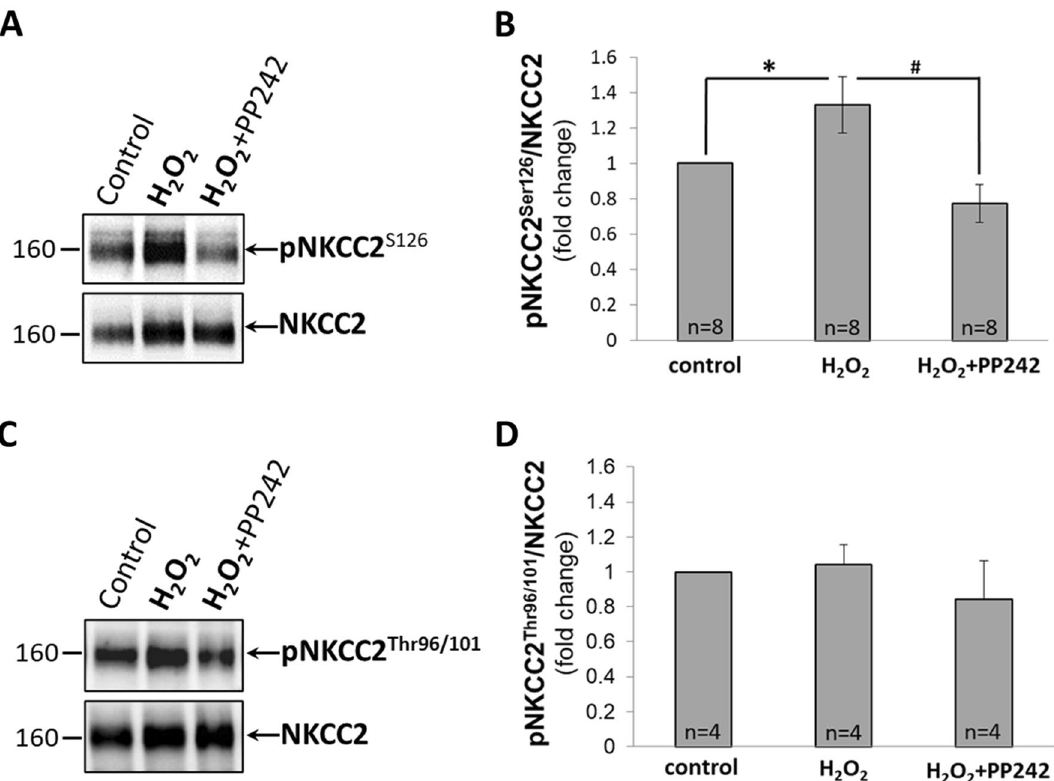
Figure 5. ( A , C ) Representative Western Blot of total NKCC2 and phosphorylated NKCC2 cotransporters (pNKCC2 Ser126 ( A ) and pNKCC2 Thr96/101 ( C )) in mTAL isolated from SD rats. mTAL incubated in HBSS for 20 min ( control ); incubated 10 min in HBSS and then with 100 µM of H 2 O 2 for another 10 min ( H 2 O 2 ); incubated with 10 µM of PP242 for 10 min and with 100 µM of H 2 O 2 for another 10 min ( H 2 O 2 + PP242 ). ( B , D ) Activity of NKCC2 cotransporters determined by densitometric quantification expressed as the ratio of pNKCC2 Ser126 ( B ) and pNKCC2 Thr96/101 ( D ) relative to total NKCC2 (n = 8 and n = 4, respectively). Data were normalized to control and represented as mean ± S.E.M. * P < 0.05 between control and H 2 O 2 treated mTAL; # P < 0.05 between H 2 O 2 treated and H 2 O 2 + PP242 treated mTAL; determined by Student’s